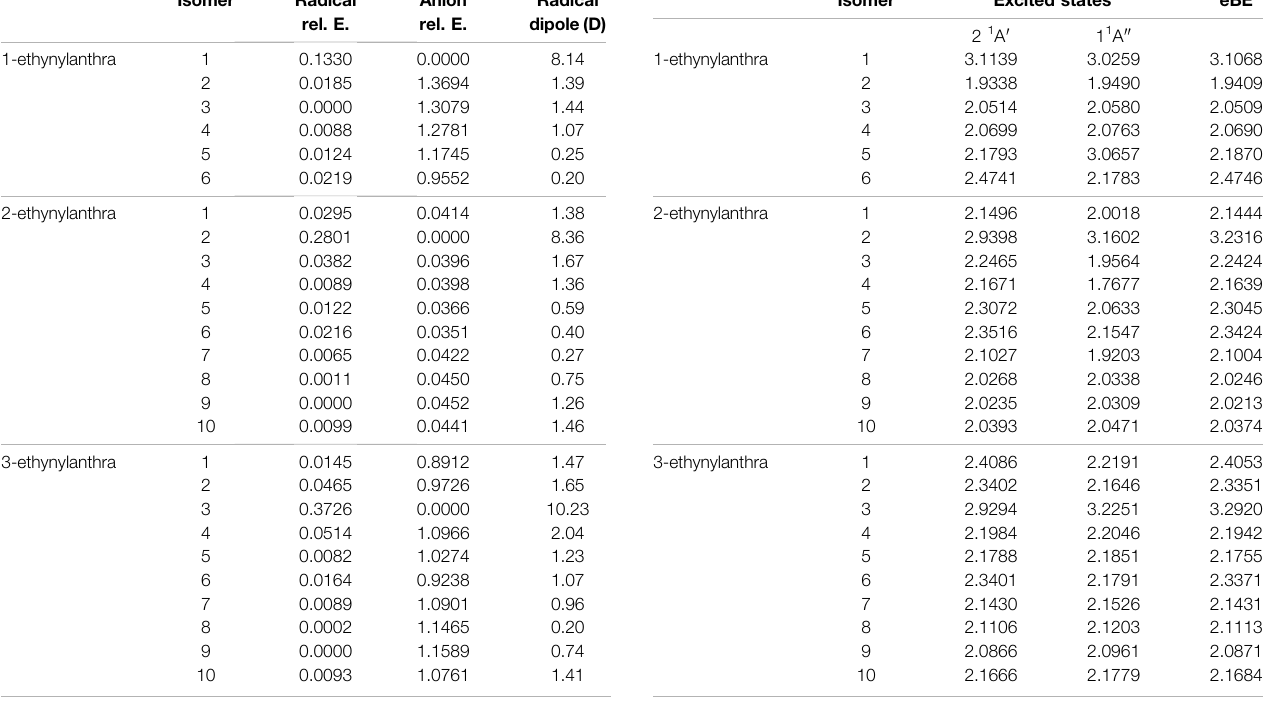
TABLE 9 | The relative energies and neutral radical dipole moments of singly TABLE 10 | The singly deprotonated ethynylanthracene anion derivatives eBEs deprotonated ethynylanthracene derivatives. and transition energies. Isomer Radical Anion Radical Isomer Excited states rel. E. rel. E. dipole(D)